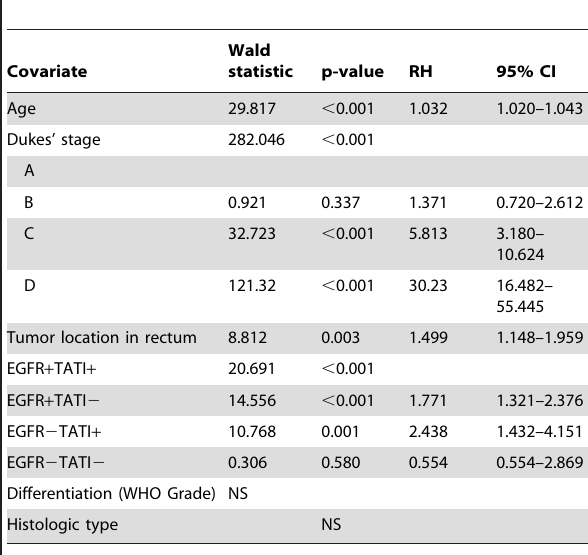
Table 6. Cox multivariate regression analysis of prognostic factors in 511 colorectal cancer